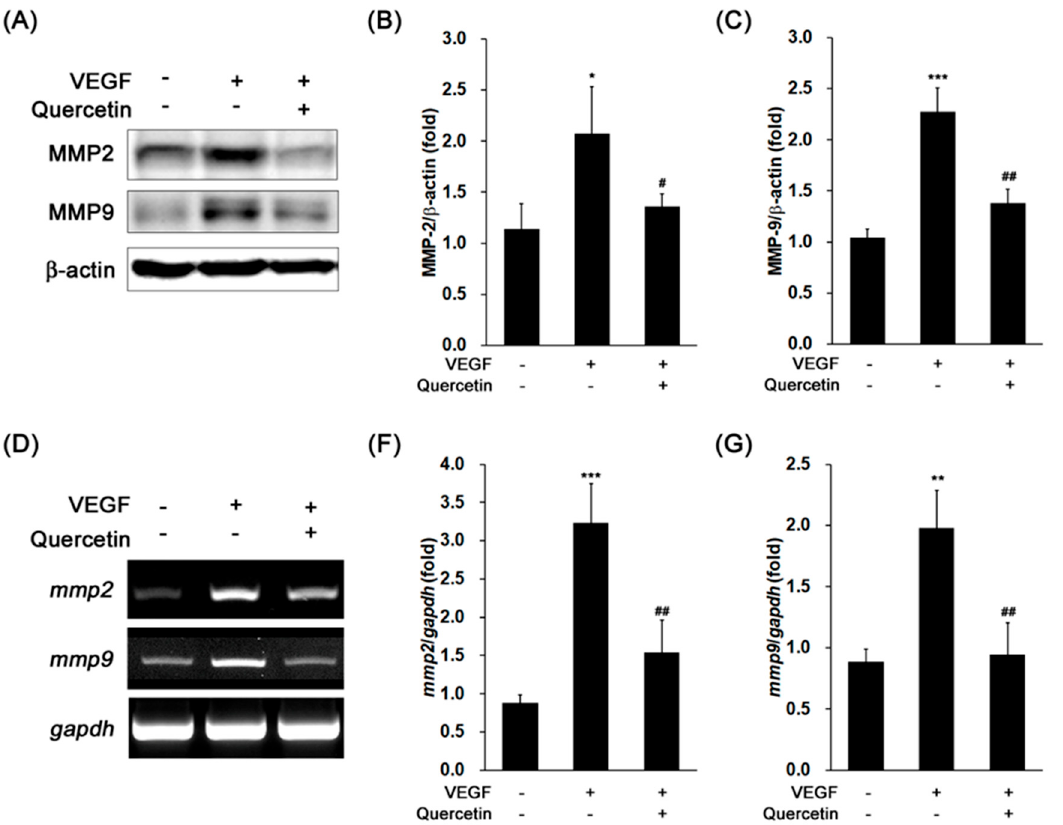
Figure 4. Effect of quercetin on the expression of MMP2 and MMP9 in VEGF-stimulated 661W cells. ( A ) Cells were treated with VEGF (20 ng/mL) in the absence or presence of quercetin (0.1 µM) for 16 h. The protein expression was detected by immunoblot. ( B , C ) Densitometry quantifications of MMP2 ( B ) and MMP9 ( C ) protein expression was measured by ImageJ. Data are the means ± SDs of three independent experiments. * p < 0.05 and *** p < 0.001 indicate significant differences compared to the non-treated control group. # p < 0.05 and ## p < 0.01 indicate significant differences compared to the VEGF-only treated group. ( D ) Cells were treated with VEGF (20 ng/mL) in the absence or presence of quercetin (0.1 µM) for 6 h. Gene expression was determined by RT-PCR. ( E , F ) Densitometry quantifications of mmp2 ( E ) and mmp9 ( F ) gene expression was measured by ImageJ. Data are the means ± SDs of three independent experiments. ** p < 0.01 and *** p < 0.001 indicate significant differences compared to the non-treated control group. ## p < 0.01 indicates significant difference compared to the VEGF-only treated group.